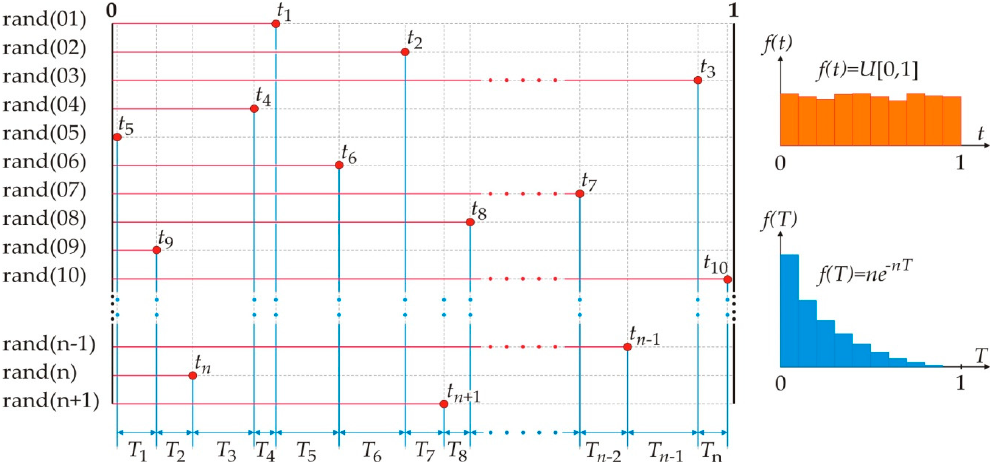
Figure 2. Fundamental concept is based on the theorem proof.